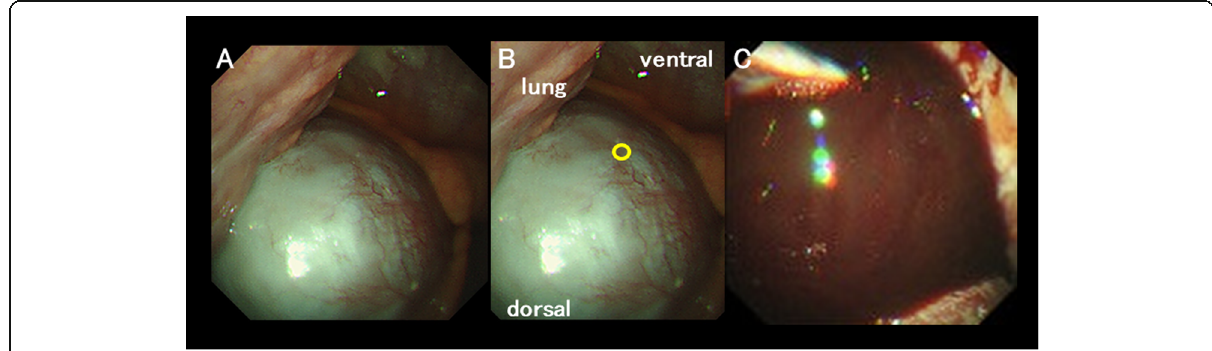
Fig. 2 Thoracoscopic findings. a Thoracoscopic examination reveals many pleural nodules and severely distended pericardium with pericardial effusion. b A tiny pericardial window, about 5 mm in diameter, was created using biopsy forceps (circle). c Bloody pericardial effusion